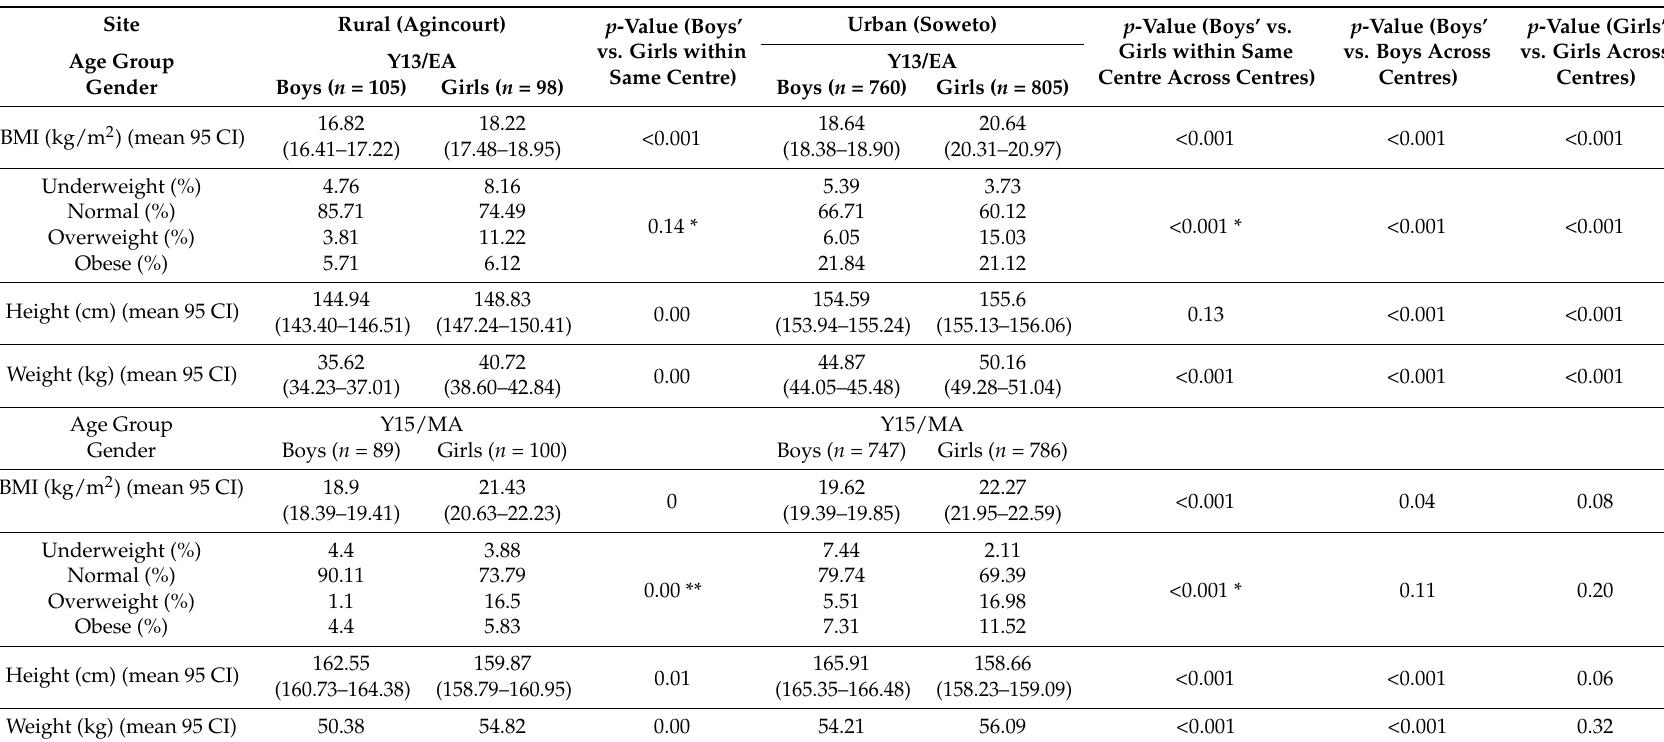
Table 1. Anthropometric characteristics of Y13/EA and Y15/MA boys’ vs. girls in rural and urban participants (means and CIs where